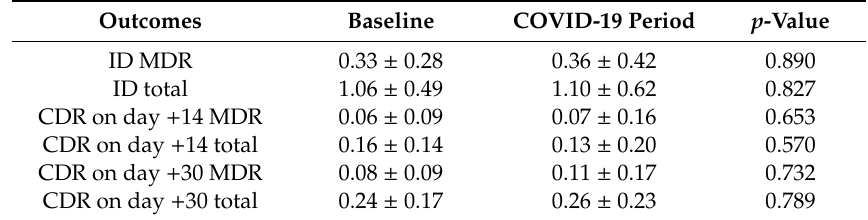
Table 2. Change in the incidence density and crude death rate of hospital-acquired bloodstream infections (BSI) between the period before the national lockdown (baseline) and the COVID-19 pandemic period. Outcomes Baseline COVID-19 Period p